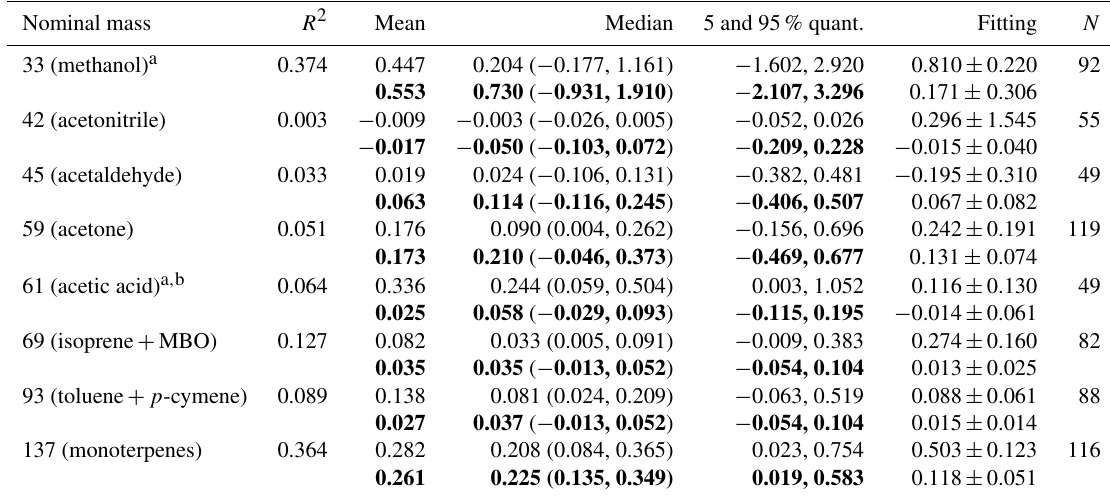
Table 3. Statistics of the major compounds of SLP and the EC flux measurements. The EC fluxes are in bold, whereas the SLP fluxes are written in normal text. The fitting parameters describe the slope (upper value) and the intercept (lower value) of the linear model between the EC and the SLP fluxes. N is the number of the data points for each compound. The numbers in parenthesis are lower and upper quartiles. The unit for the mean, median, intercept and quantile values is nmolm − 2 s − 1 .